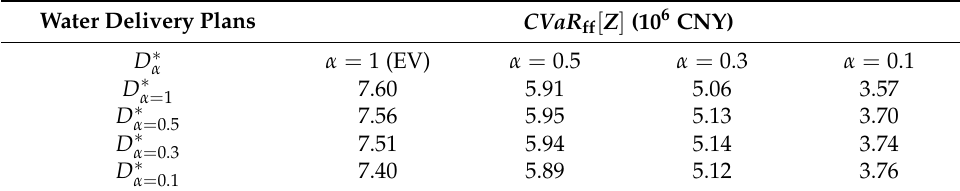
Table 2. Water delivery plans and statistics of the results.